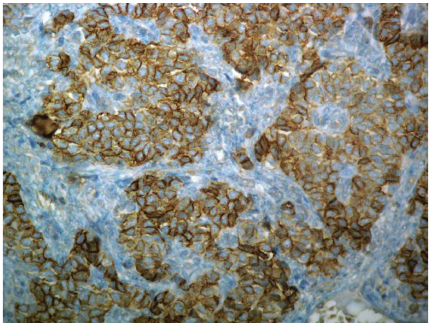
Figure 4: Tumor cells present strong membrane reaction to CD99 (DAB, Haematoxylin ×